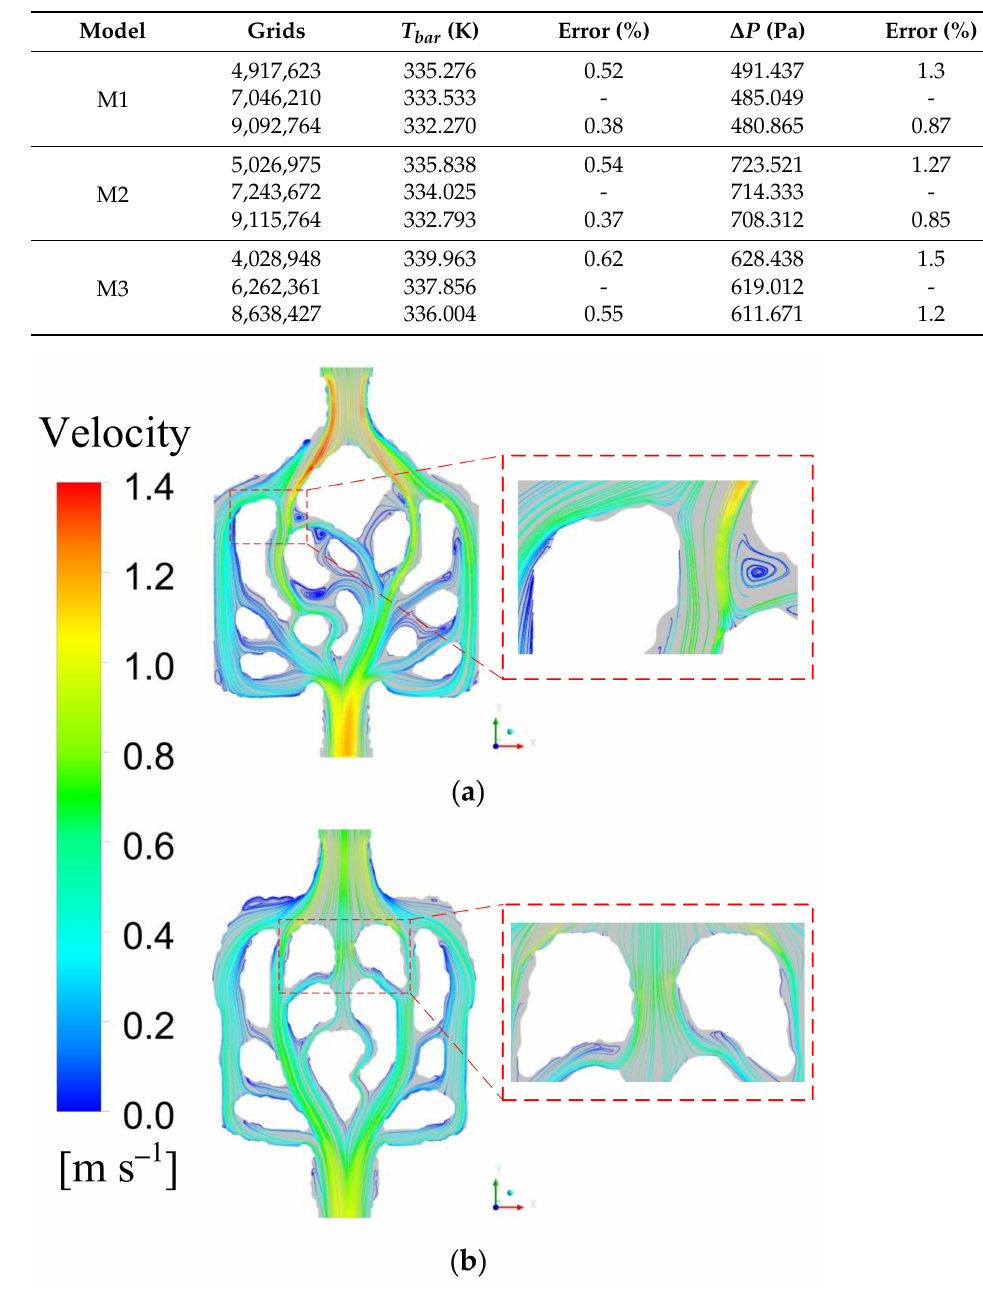
Figure 6. Fluid velocity distribution for M1 and M2 for u f in = 0.7 m/s. ( a ) M1; ( b )